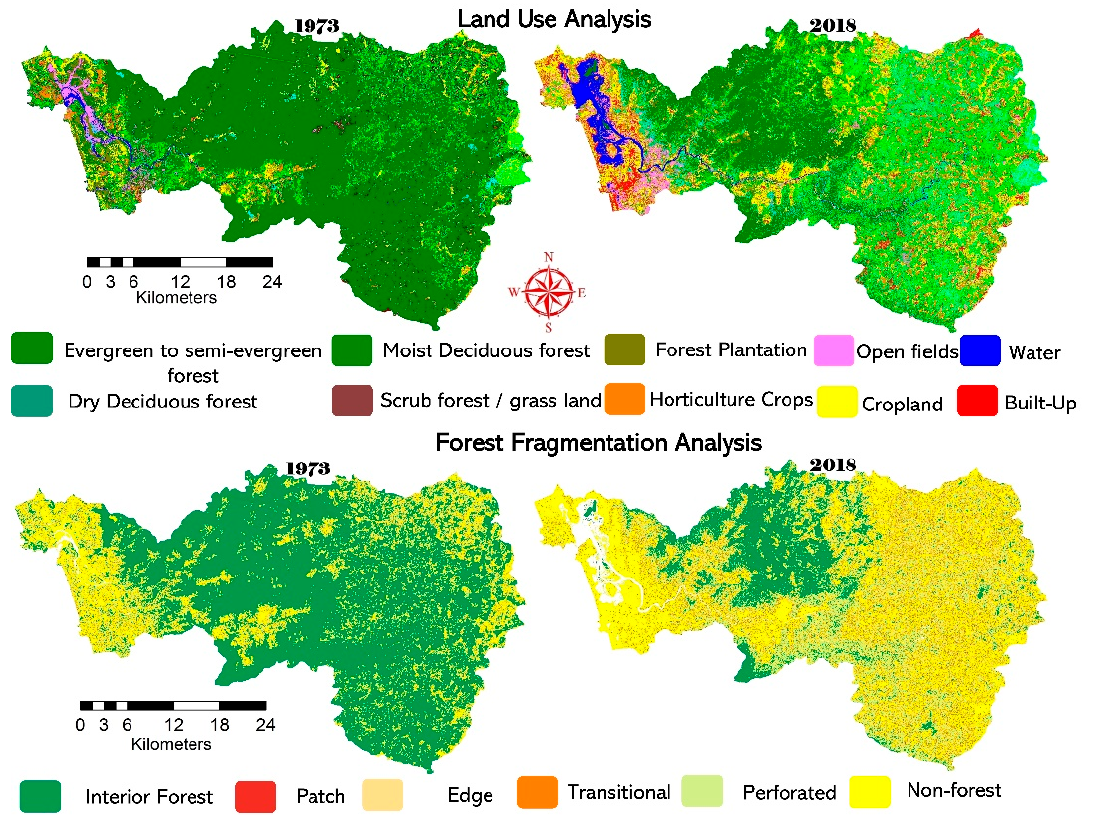
Figure 3. Land uses and extent of forest fragmentation in the Aghanashini River catchment.